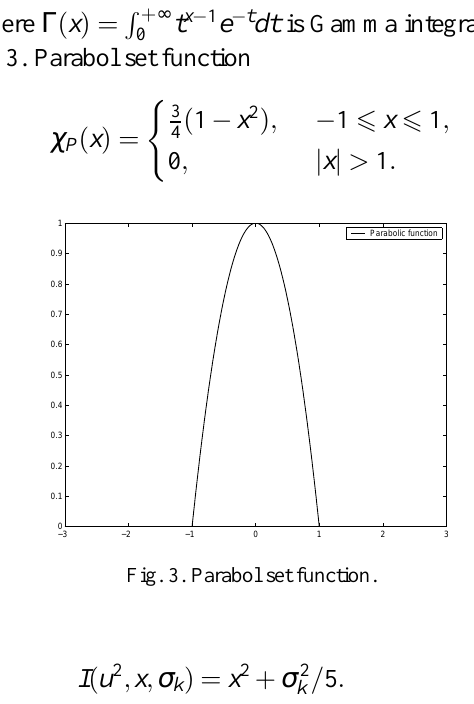
Fig. 5. Spline set